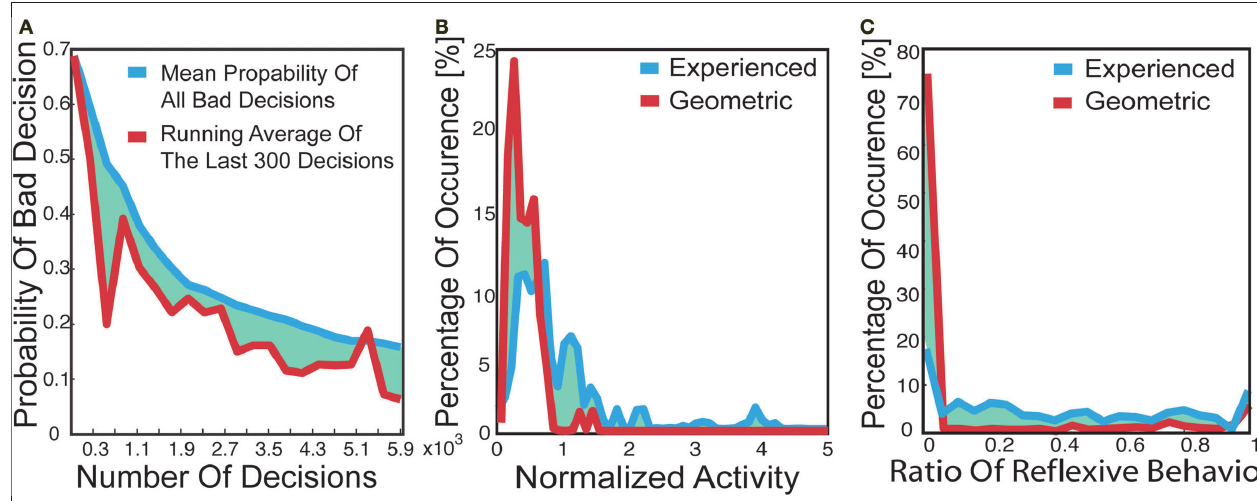
Figure  | (A) Mean contribution to the transition probabilities of the bad decisions. Bad decision is defined as a low correlation between actions outcome and the direction of the intended action. (B) Occurrence of normalized activity in the decision-making process. (C) Ratio of executed actions which resulted in reflexive